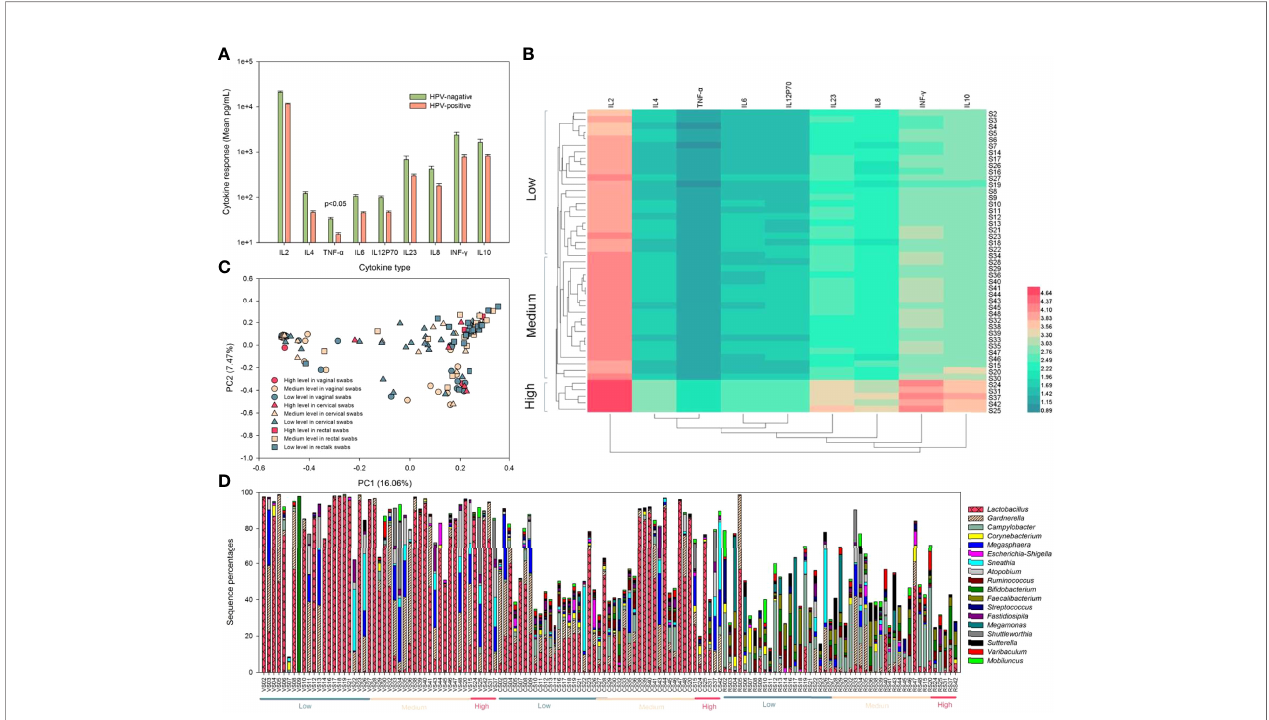
FIGURE 5 | Cytokine determination, grouping, and effects on microbial community composition. (A) Cytokine determination with a logarithm of 10 in HPV-negative (light green) and HPV-positive samples (light pink). (B) All samples were clustered to low, medium, and high levels to determine correlation coef fi cients between individual cytokines according to cytokine levels (logarithm of 10) by average linkage cluster. (C) PCA plot based on the relative taxon abundance in vaginal, cervical, and rectal swab samples with low, medium, and high levels of cytokine clusters. (D) Relative microbial abundance determined using 16S rRNA gene sequencing clustered by low, medium, and high levels of cytokines in vaginal, cervical, and rectal swab